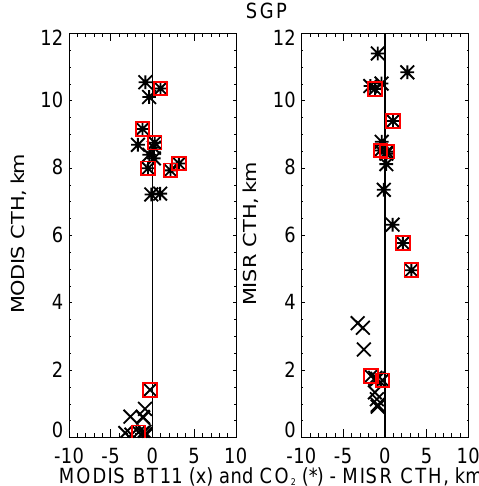
Fig. 6. MODIS (left) and MISR (right) cloud-top heights vs. the dif- ference between MODIS and MISR cloud-top heights for all cases found at SGP, with BT11 cases marked as (x), CO 2 -slicing as (*) and cases with a radar retrieval and a multilayer situations squared.